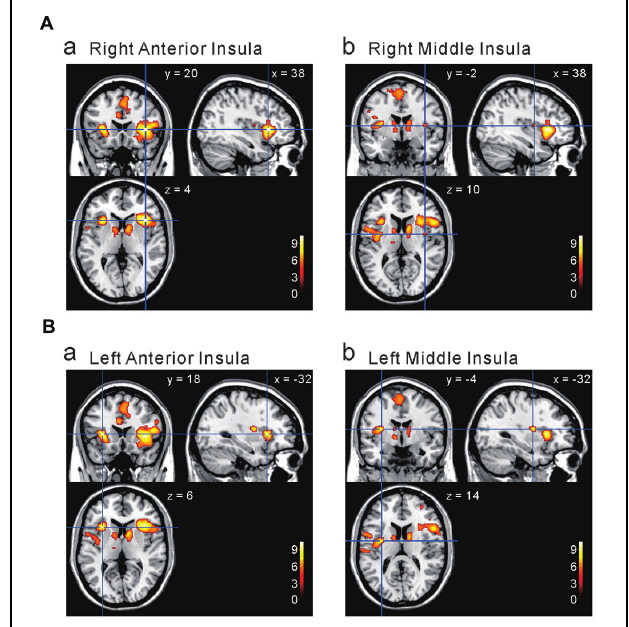
FIGURE 3 | Brain areas significantly activated by the comparison [Capsaicin–AS]. (A,B) The anterior and middle insula activated by capsaicin stimuli. ( x, y, z ) values represent Montreal Neurological Institute (MNI) coordinates (mm), and the color bar represents the T